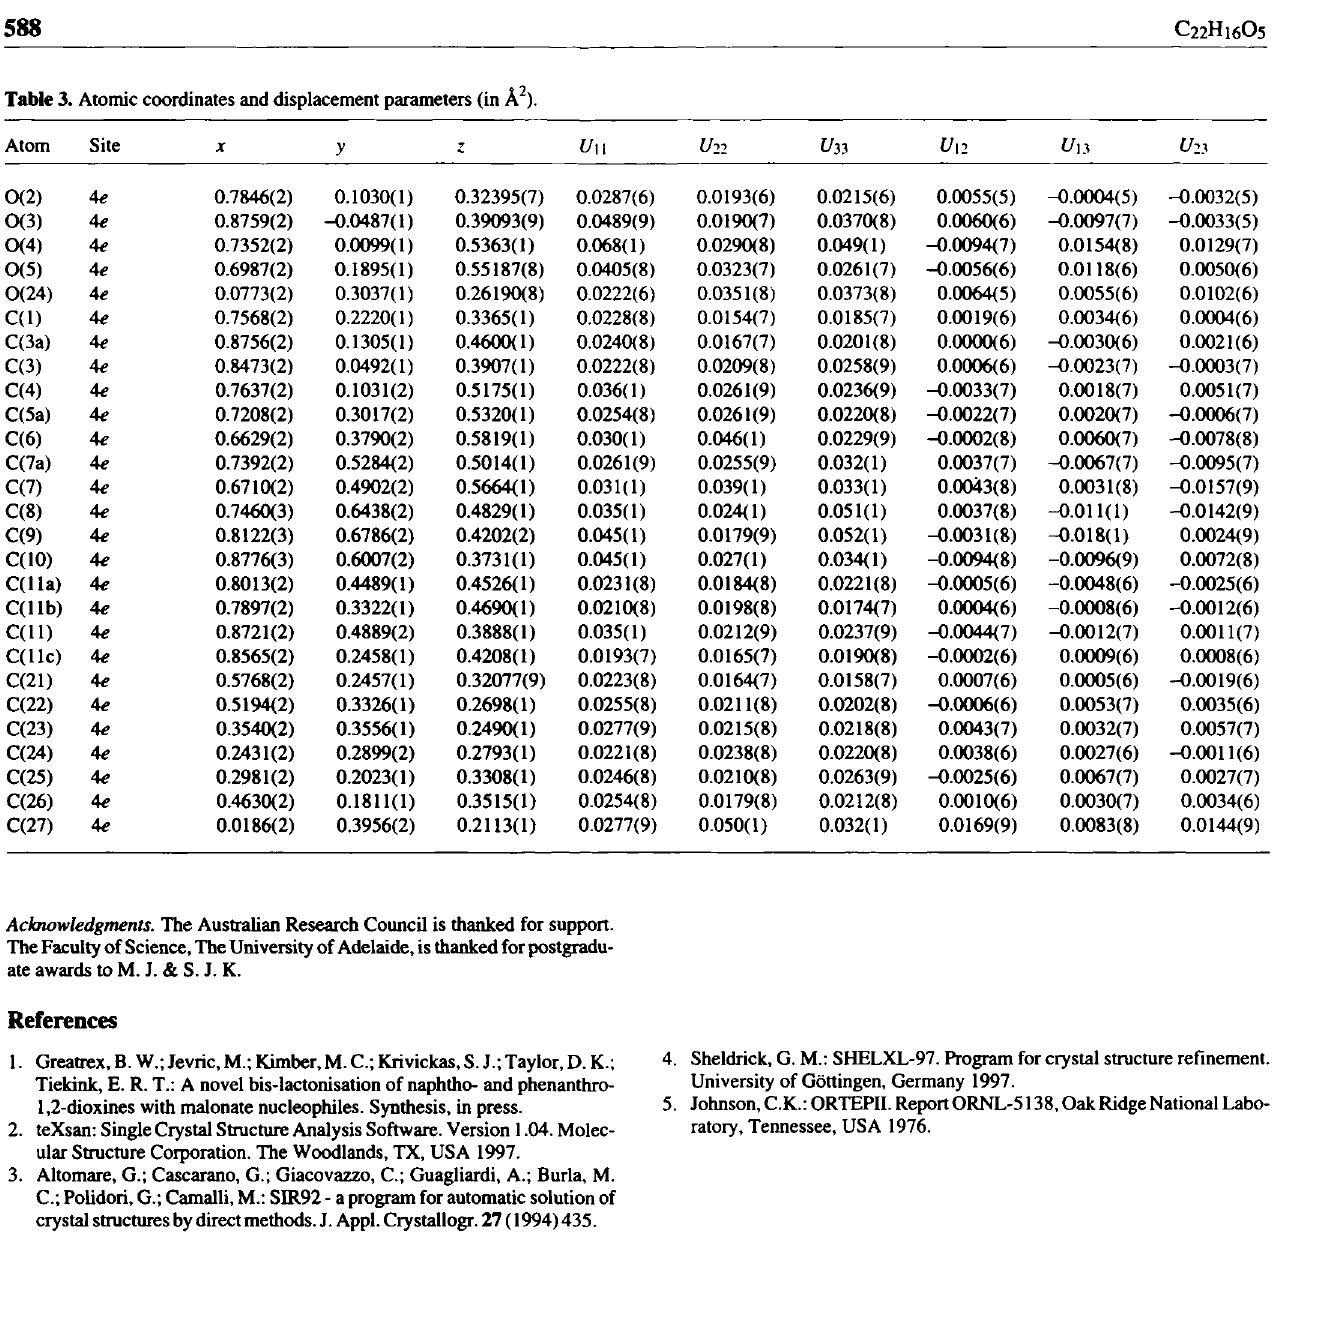
Table 3. Atomic coordinates and displacement parameters (in Â 2